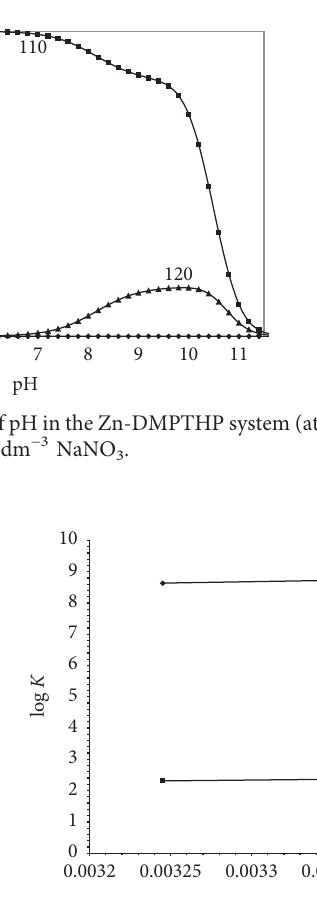
Figure 10: Effect of temperature on the formation constant of Zn(II)-DMPTHP complexes. � 0.1 mol · dm − 3 2 O (V/V) solution at I